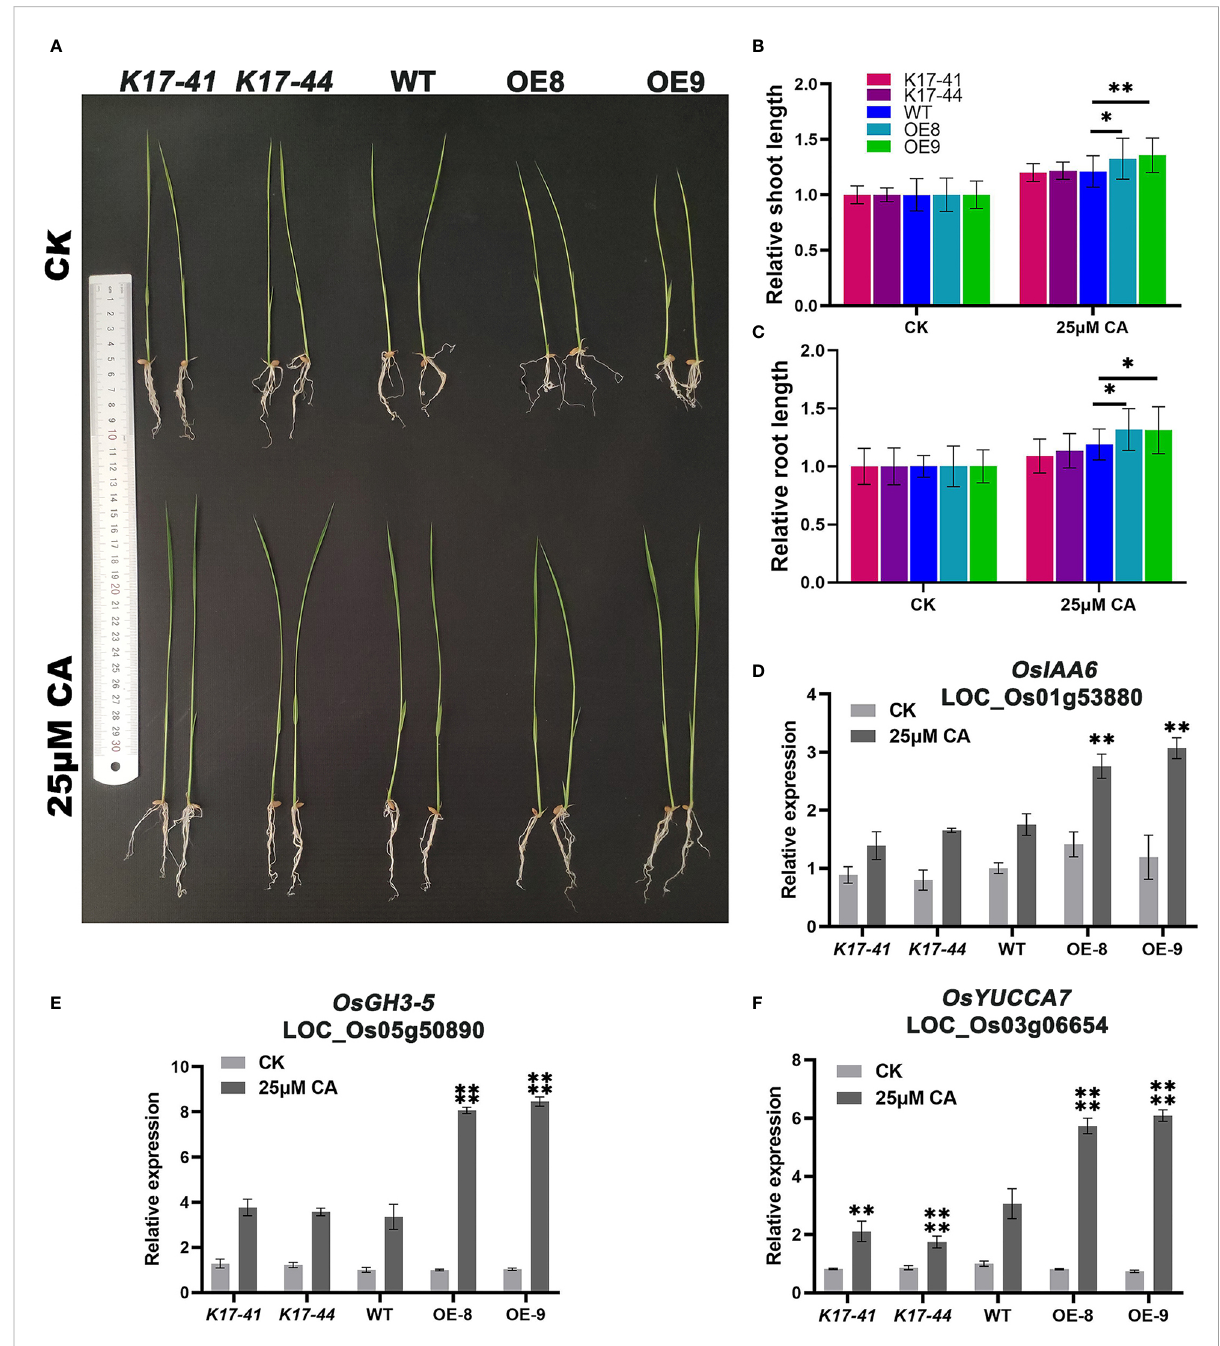
FIGURE 7 Exogenous citric acid stimulates the growth of OsCIPK17 -OE plants. (A) Growth performance of OsCIPK17 -OE, OsCIPK17 -Mutant, and WT seedlings grown in clear water with or without 25 m mol·L -1 . (B) Relative shoot length and (C) relative root length of OsCIPK17 -OE, OsCIPK17 - Mutant, and WT seedlings grown in clear water with or without 25 m mol·L -1 at 14 days after germination. (D – F) are the expression levels of citric acid treated and controlled with auxin-related genes in (A) . Relative expression levels of the gene were normalized to the internal control of the OsACTIN-1 ( LOC_Os05g36290 ) gene. Data in (B – F) are presented as mean ± SD of three independent experiments, and signi fi cant differences between sCIPK17 -OE/ OsCIPK17 -Mutant and WT plants according to one-way ANOVA are indicated by asterisks. Asterisks indicate signi fi cance (*p < 0.05, **p < 0.01,